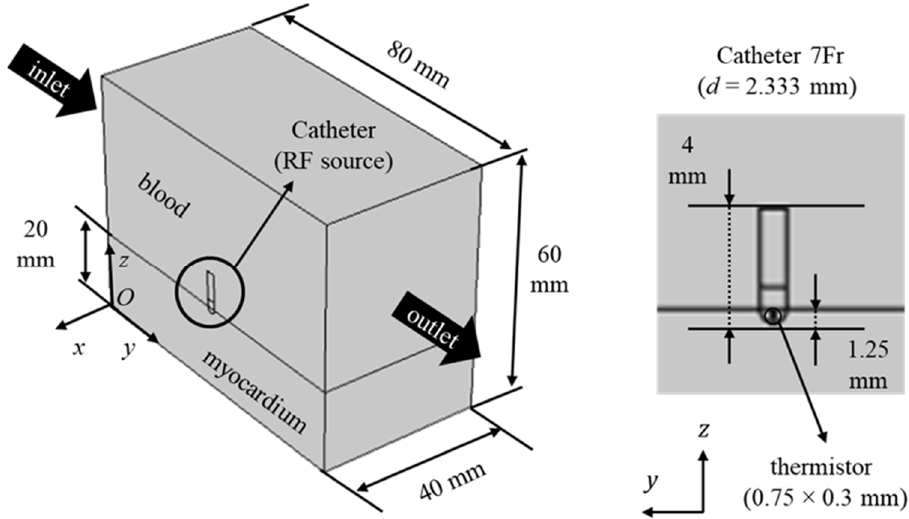
Figure 1. Computational domain for RF cardiac ablation.